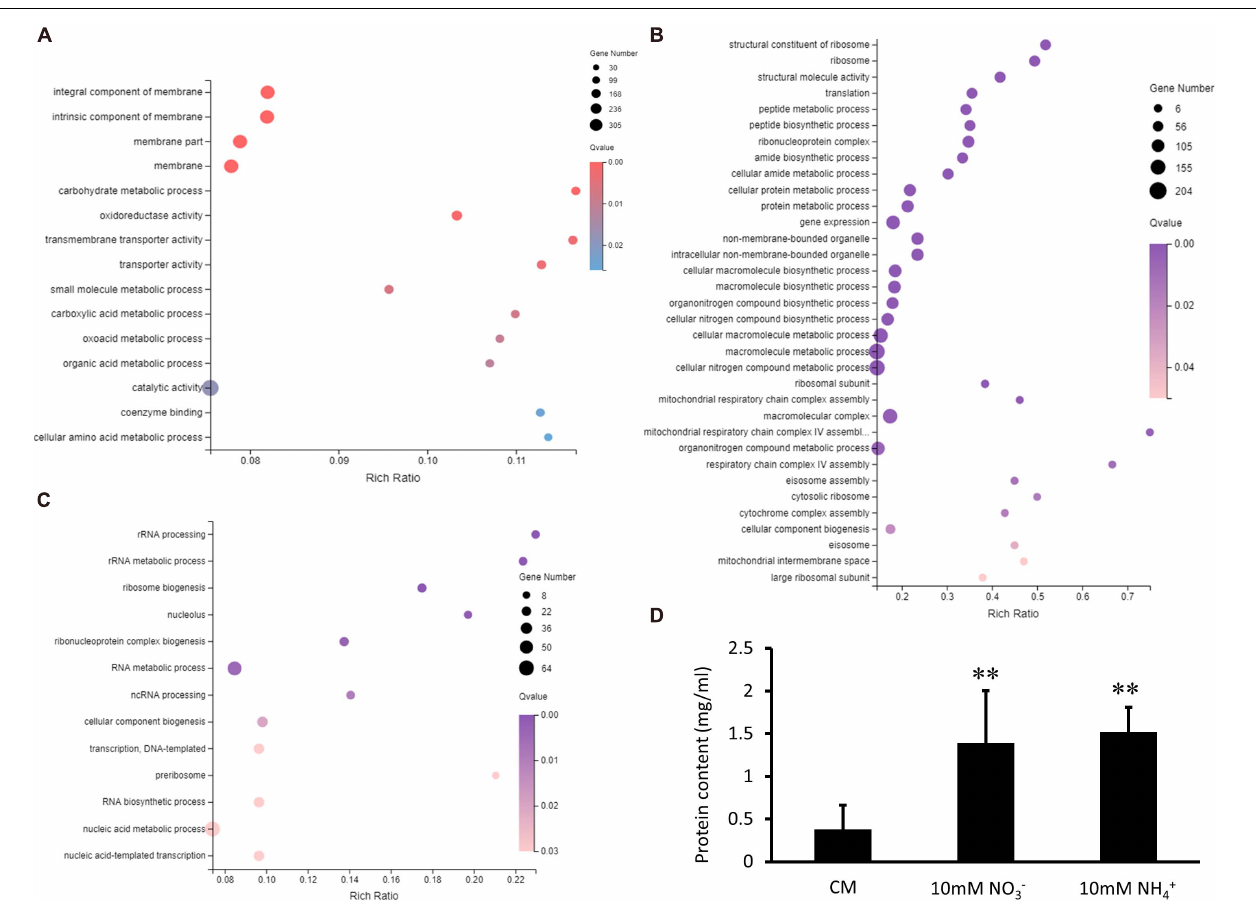
FIGURE 8 | Enrichment analyses of differentially expressed genes (DEGs) in Verticillium dahliae in response to different nitrate sources. (A) A bubble chart showed DEGs depressed in both groups were enriched in 15 gene ontology (GO) terms. The size of the bubbles is proportional to the total number of DEGs. The X -axis represents the enrichment ratio and the Y -axis represents GO term. (B) A bubble chart showing DEGs whose expression was increased in nitrate utilization and enriched in 34 gene ontology (GO) terms by using a GOseq R package mentioned in section “Materials and Methods.” The size of the bubbles is proportional to the total number of DEGs. The X -axis indicates the enrichment ratio, and the Y -axis indicates the GO terms. (C) A bubble chart showing DEGs downregulated in nitrate utilization and enriched in 16 GO terms. The size of the bubbles is proportional to the total number of DEGs. The X -axis indicates enrichment ratio, and the Y -axis indicates GO terms. (D) Bar chart showing the protein content of the XS11 strain treated with 10 mM NO3 − or 10 mM NH4 + for 24 h. Error bars represent the standard deviation based on three independent replicates. Asterisks indicate significant differences ( ∗∗ P < 0.01; ∗ P <